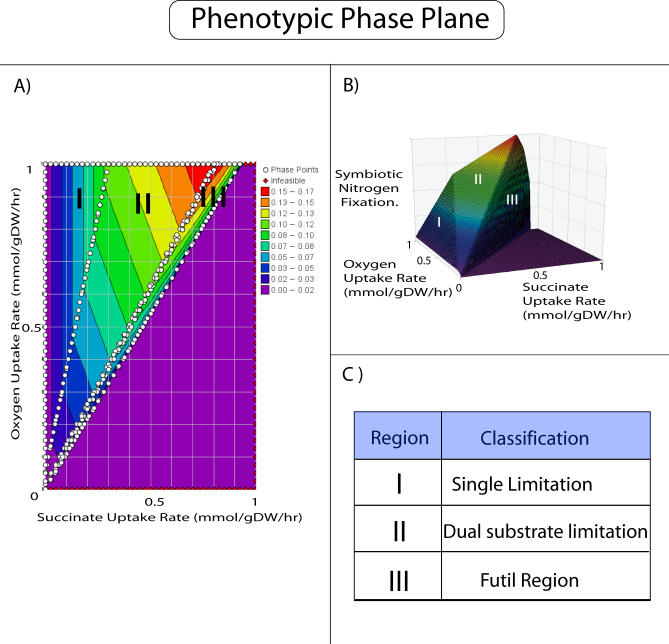
Phenotype Phase PlaneThe phenotypic phase plane shows the dependence of symbiotic nitrogen fixation on succinate and oxygen uptake rates. Succinate and oxygen uptake rates are expressed in mmol/gDW/hr. The OF has the same units, and its magnitude is expressed by the color scale (A). Regions denoted by I, II, and III characterize qualitatively different phenotypes in the phase plane (C). The phase plane is shown in 2-D (A) and 3-D (B).